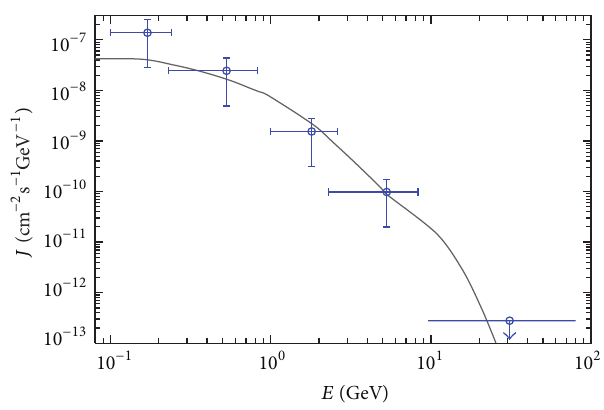
Figure 2: Expected spectrum from ] 4 ] 4 -annihilation is shown for = 47 GeV in comparison with the observed spectrum of 𝑚 ] 4 unidentified source 2FGL